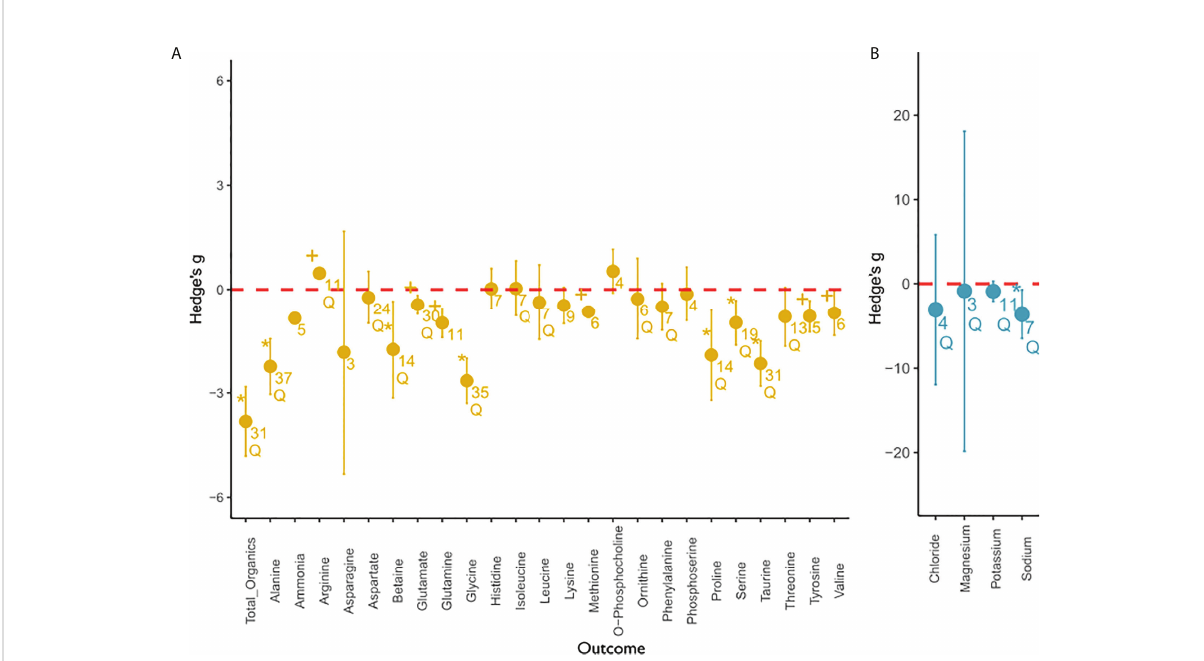
FIGURE 4 Overall meta-analysis of the salinity effect on (A) organic and (B) inorganic compounds. This fi gure depicts the overall effect of low salinity on solute concentration of organic compounds (yellow) and inorganic compounds (blue) from the random-effects meta-analysis. Individual outcome variables (compounds) are depicted on the x-axis and the effect sizes expressed as Hedge ’ s g are depicted on the y-axis. The mean effect size for each outcome variable is depicted as a circle with the error bars indicating robust con fi dence intervals (95%). If the con fi dence intervals do not overlap with zero (marked in red), an effect size is considered signi fi cant. If error bars are not visible, they are smaller than the data point. An asterisk indicates a signi fi cant, robust difference in effect size that passed sensitivity analysis. Results that were signi fi cant but were fl agged during sensitivity analysis were marked with a plus. Q indicates signi fi cant residual heterogeneity as tested with the random effects model. Numbers below circles indicate k — the number of studies. All outcome variables can be considered intracellular, except for magnesium. Magnesium concentrations were reported for tissues